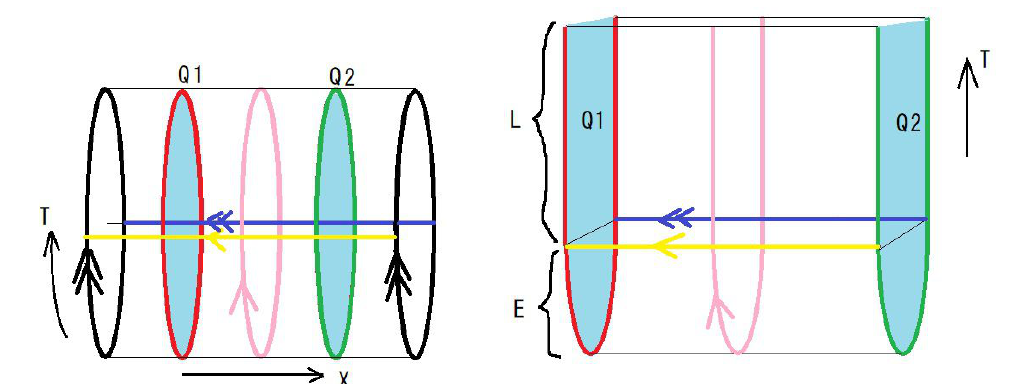
Figure 34 . The picture of the dual geometry in the BTZ phase. The left (cid:12)gure describes Euclidean geometry, and the right (cid:12)gure describes Lorentzian time evolution. In this case we impose the dual boundary surface has two connected components Q 1 ; Q 2